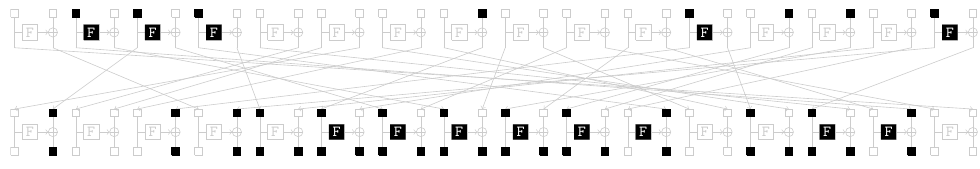
Figure 7: Example of difference propagation over N f = 2